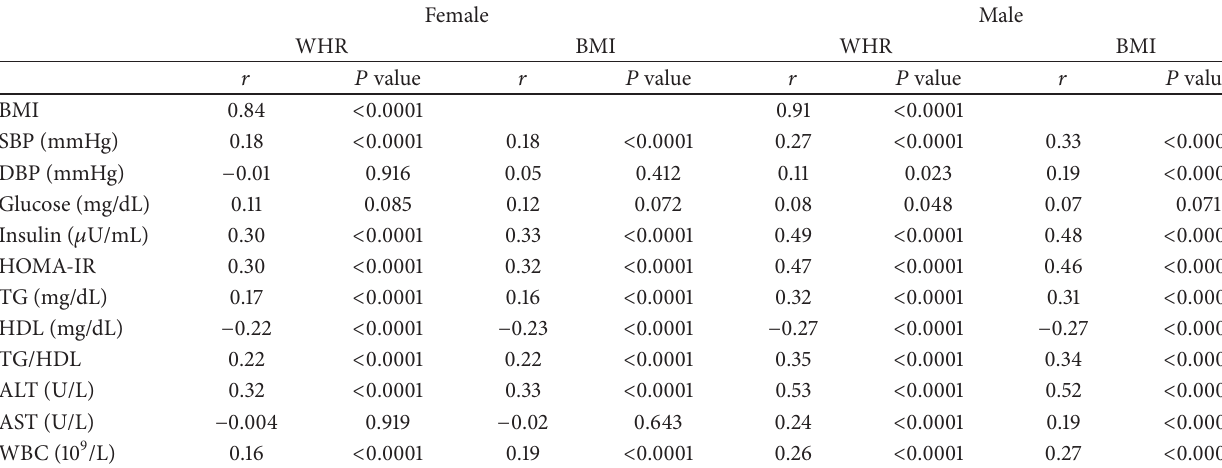
Table 3: Correlations between WHR or BMI and metabolic syndrome components in 13–18-year-old male and female adolescents. Female Male WHR BMI